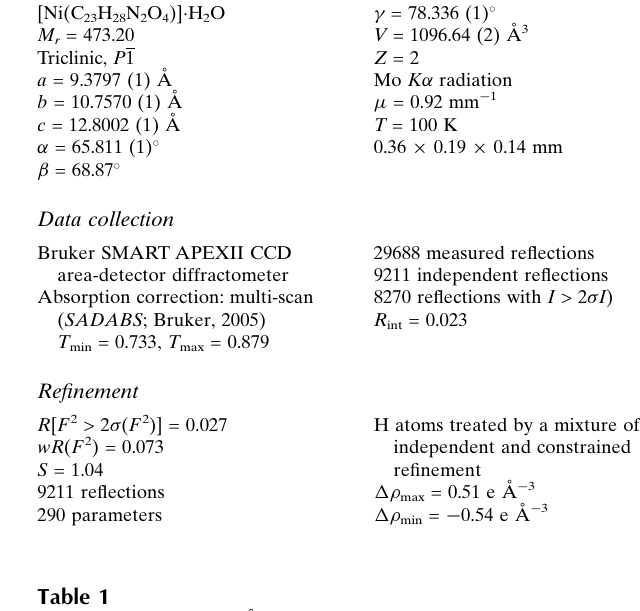
Selected bond lengths (A˚ ).